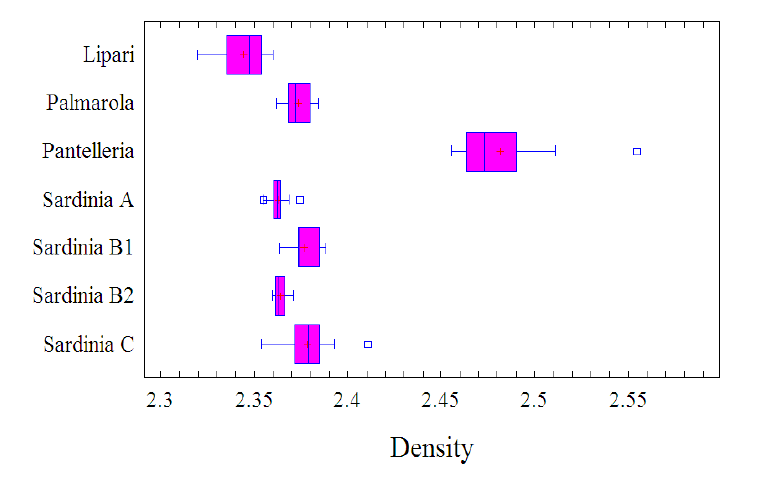
Figure 8. Box plot of density for central Mediterranean obsidian geological samples.